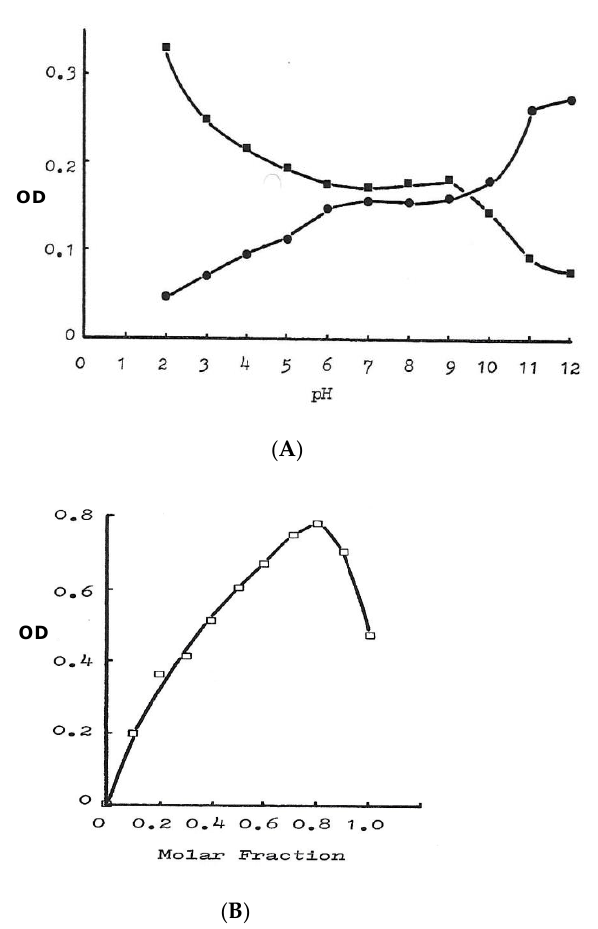
Figure 4. Characterisation of the maltol iron complex. ( A ) Stability of the maltol iron complex over a wide pH range. Titration of a mixture of maltol (0.75 mM) and iron (0.25 mM) at a pH range 2 – 12, indicating one iron complex species of red/orange colour at the pH 6 – 10 range. The optical density (OD) monitoring was carried out at the wavelengths of 320 nm (circles) and 280 nm (squares) [25]. ( B ) Identification of the stoichiometry of the tris-maltol iron complex at physiological pH. Estimation of the stoichiometry of the maltol iron complex using the Job’s plot method. Measurement of the optical density (OD) at 220 nm of different molar fraction mixtures of maltol (1 mM) and iron (1 mM) at pH 7.0. The horizontal axis refers to the molar fraction of maltol. An octahedral structure iron complex similar to deferiprone and other bidentate chelators is formed in the interaction of maltol with iron at physiological pH (Figures 3 and 4). A proton is released from the coordinating hydroxyl group of maltol on binding ferric (3+) iron, forming three negatively charged maltol molecules (Figures 3 and 4) and an overall neutral trimaltol ferric iron complex. Both maltol and the maltol iron complex are lipophilic and have a neutral charge at physiological pH (Table 4).